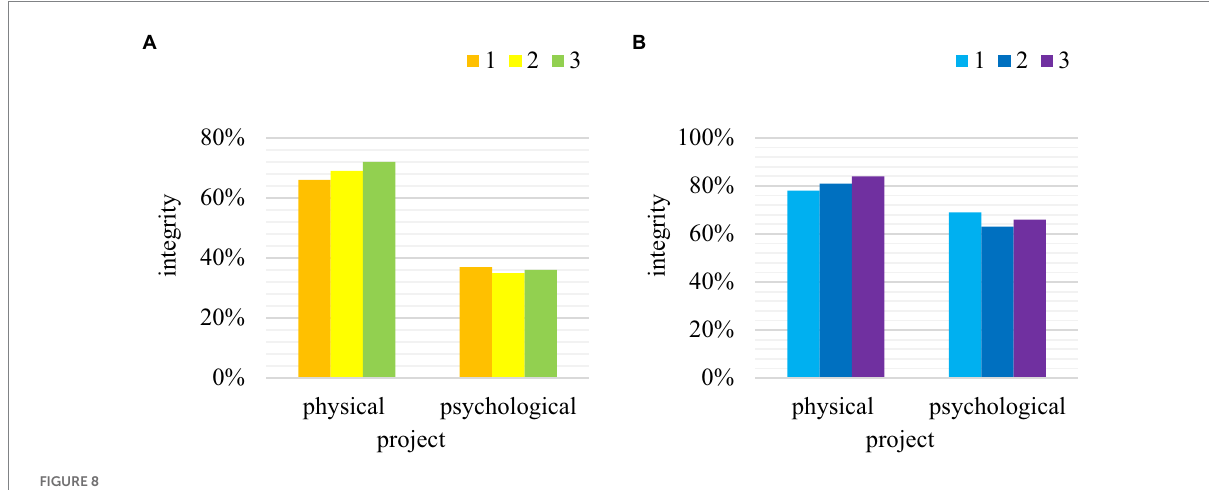
FIGURE 8 Comparison of teaching integrity. (A) Traditional teaching. (B) New